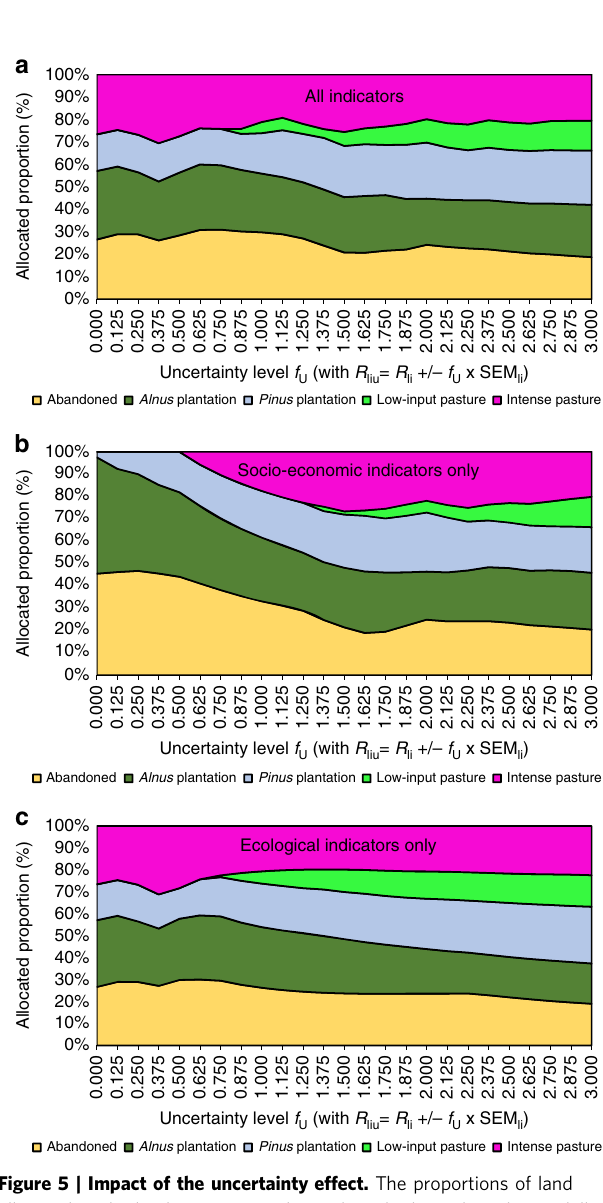
single services among land-cover types and, thus, to a buffering effect of the sometimes high uncertainties of the indicator values